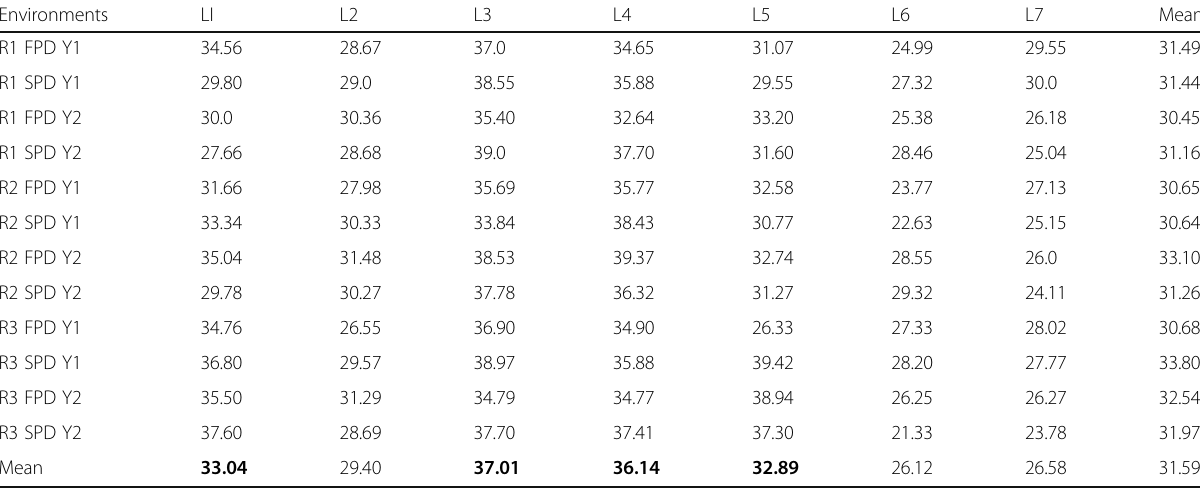
Table 7 The mean values for the seven rice entries under the 12 environments for number of panicles/plant